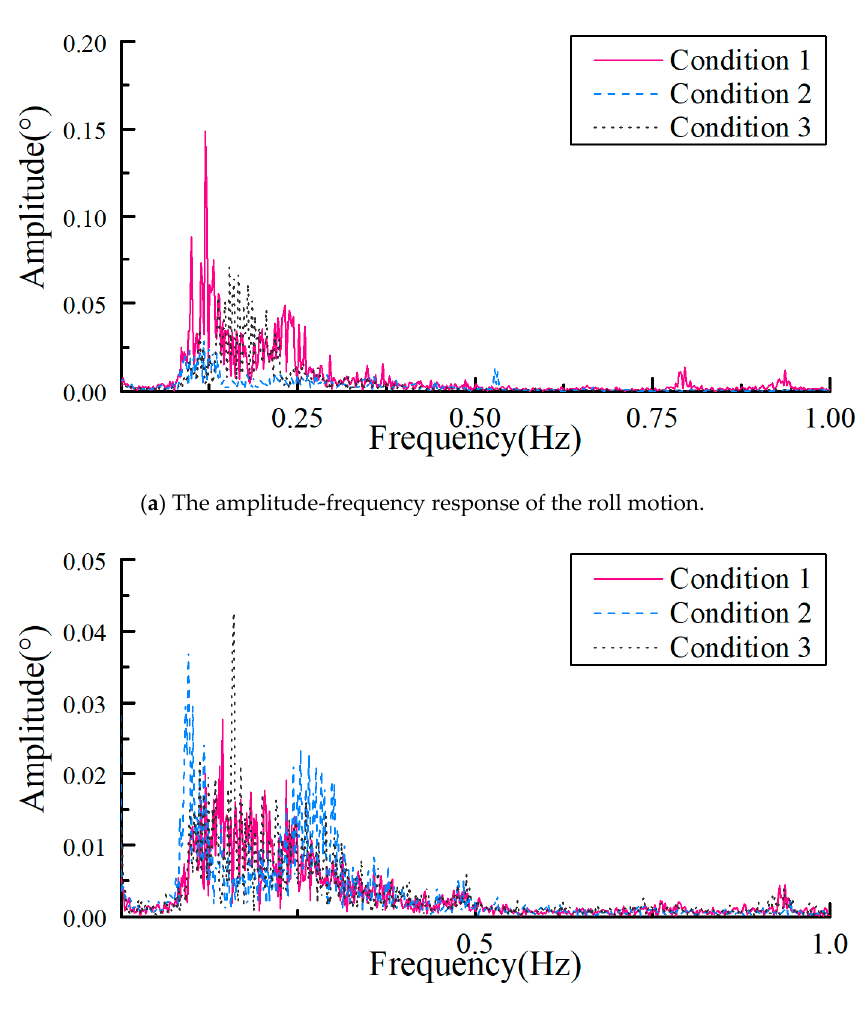
Figure 11. The amplitude-frequency response of the roll and pitch.